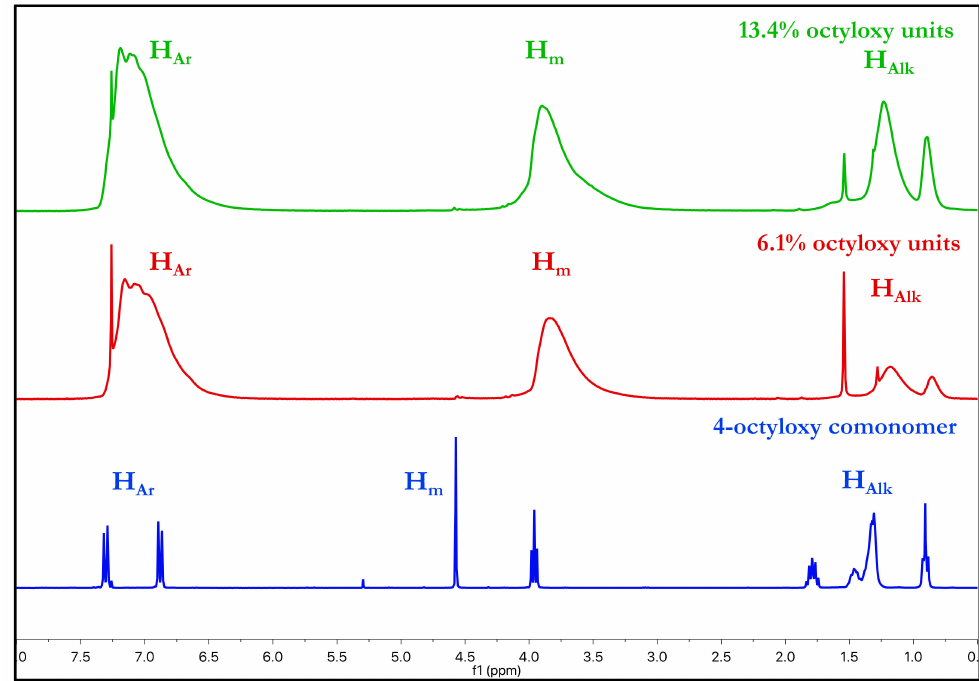
Figure 3. 1 H NMR spectra. From the bottom to top: 4-octyloxybenzyl chloride (blue line), copolymer with 6.1% mol / mol (red line), and 13.4% mol / mol 4-octyloxybenzyl-containing constitutional repeat units (green